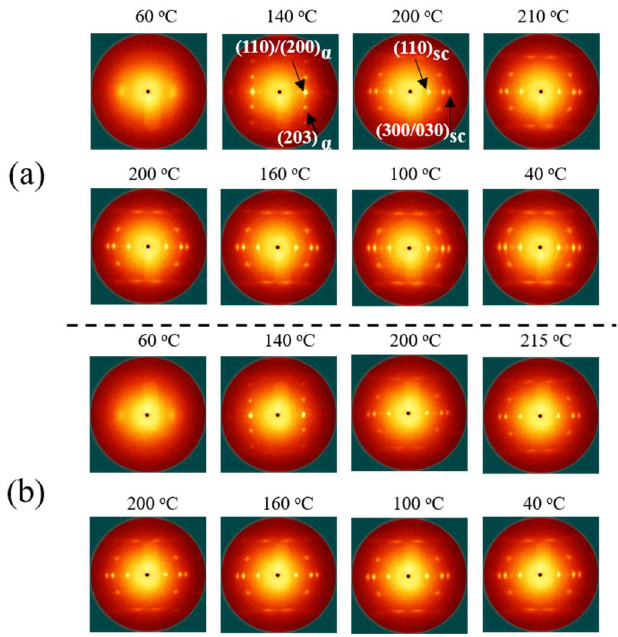
Figure 5. Selected 2D WAXS patterns of PLLA/PDLA-60-2 fibers during heating to 210 °C ( a ) and 215 °C ( b ), and the following cooling process.